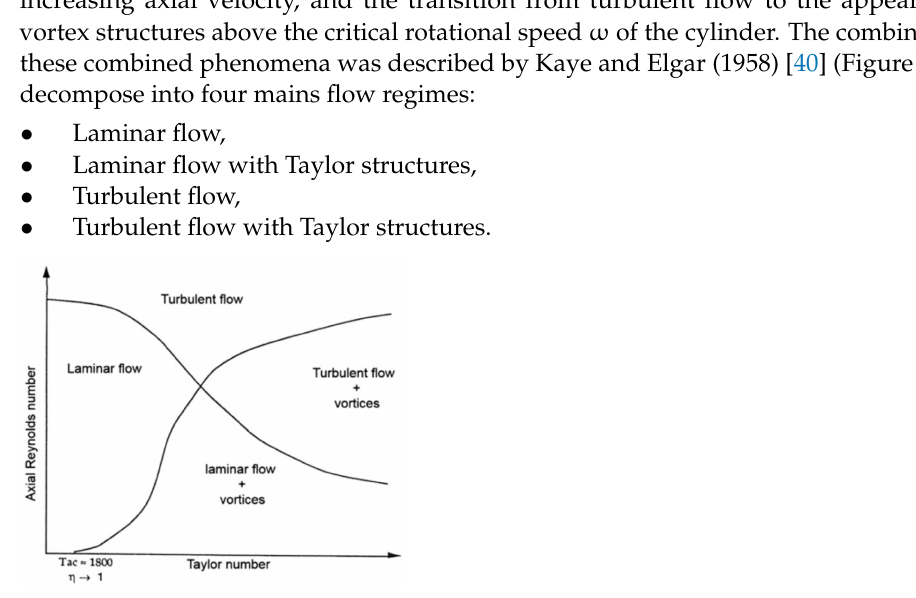
Figure 4. Flow regimes as a function of axial Reynolds number and Taylor number